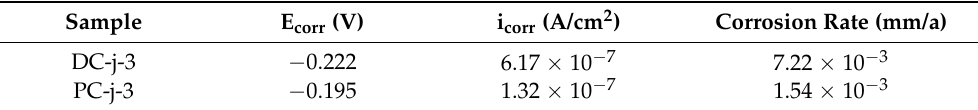
Table 6. The corrosion parameters of the Ni-Co/WS 2 nanocomposite coatings with different elec- trodeposition